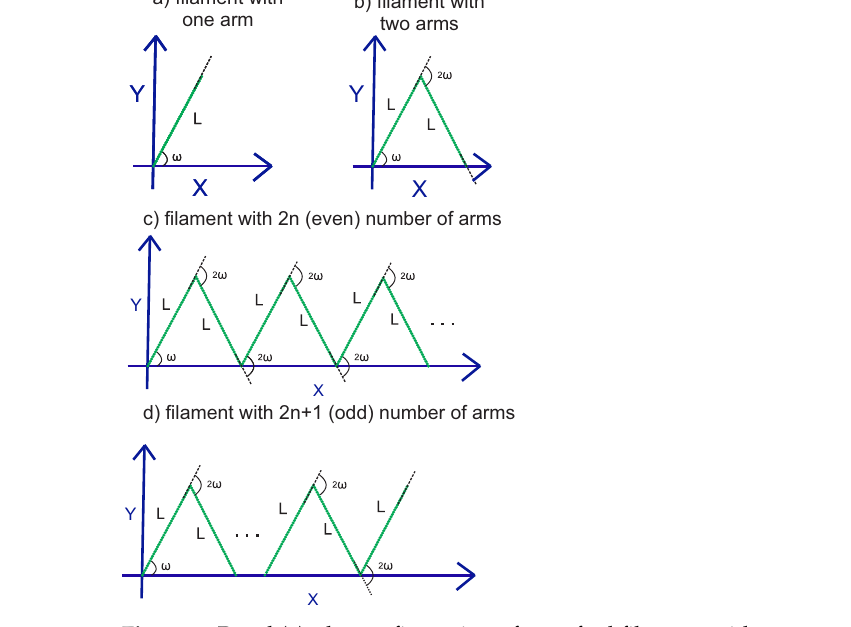
Figure 2. Panel ( a ): the configuration of a grafted filament with one arm (unkinked filament). The grafting angle is ω , and the arm has a contour length L and the persistence length l p . Panel ( b ): the configuration of the filament with two arms (filament with one kink). Each arm has a contour length L and a persistence length l p . The grafting angle is ω , and the kink angle is 2 ω . Panel ( c ): the configuration of a filament with regular kinks and an even number of similar arms of contour length L and persistence length l p . Panel ( d ): the configuration of the filament with regular kinks and an odd number of similar arms of the contour lengths L and persistence length l p . All of the configurations shown in this figure are at zero